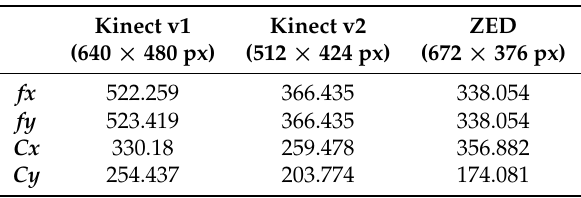
Table 1. Intrinsic parameters for the tested sensors.